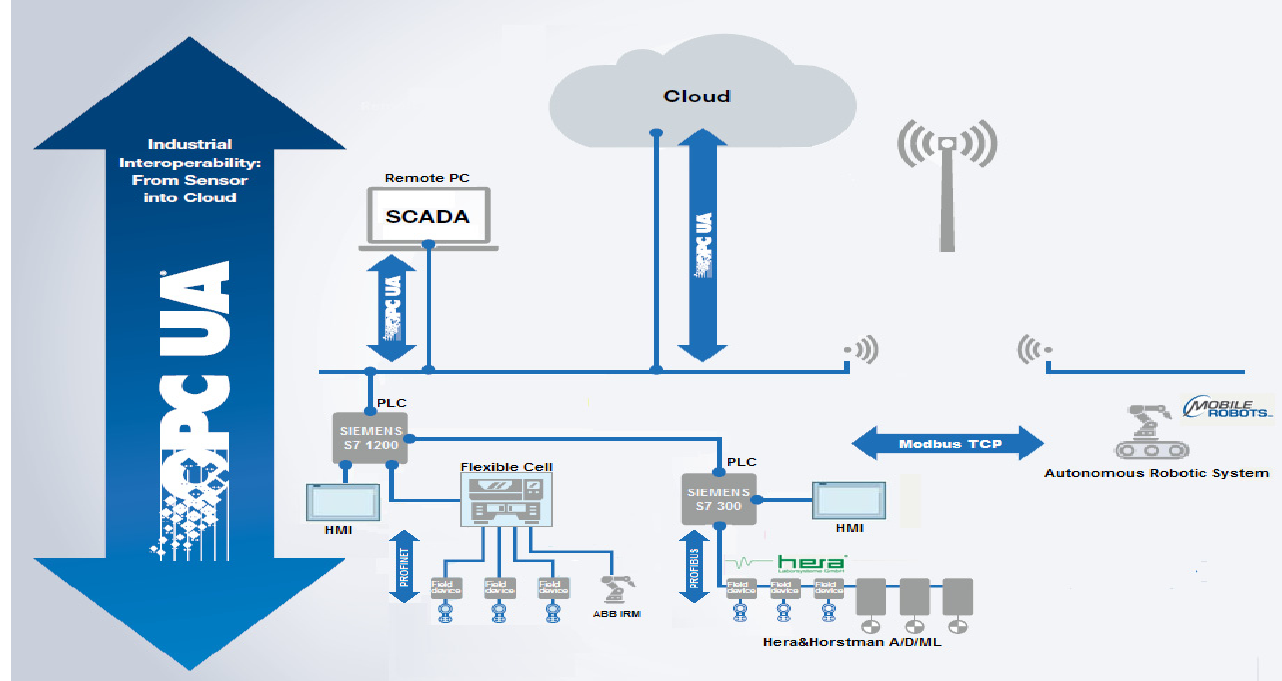
Figure 19. Control structure of A/DML Hera&Horstmann and Flexible Cell ABB served by ARS.